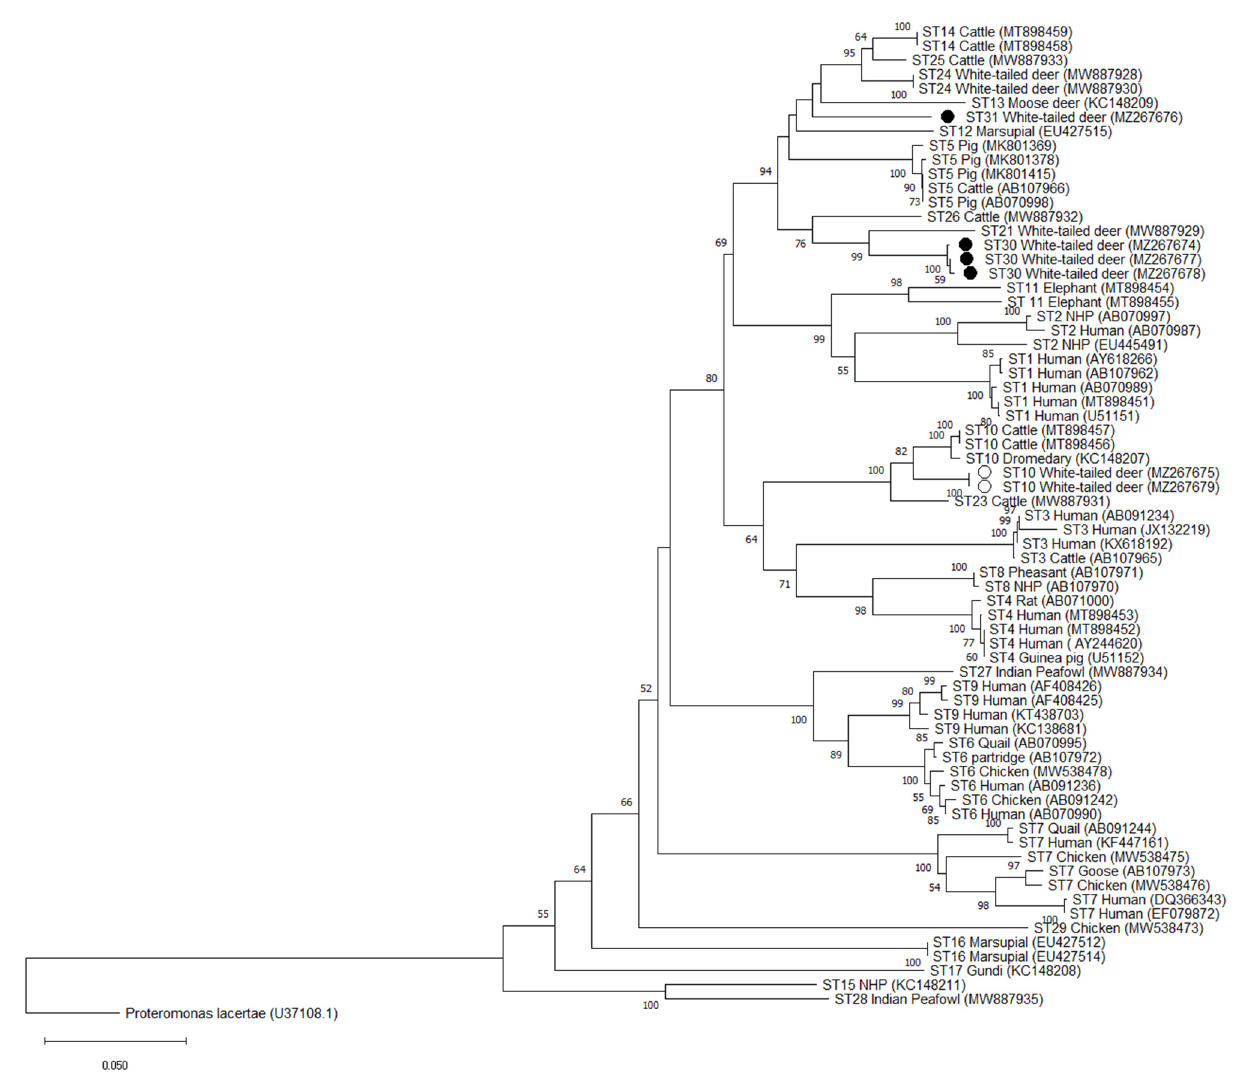
Figure 4. Phylogenetic relationships among Blastocystis Santin region sequences generated in the present study (novel subtypes represented are with a black filled circle and other subtypes with an unfilled circle) and representative reference sequences of all accepted subtypes. Proteromonas lacertae was used as outgroup taxon to root the tree. Analysis was conducted using a neighbor-joining method. Genetic distances were calculated using the Kimura two-parameter model. This analysis involved 70 nucleotide sequences, and there were a total of 571 positions in the final dataset. Bootstrap values lower than 50% are not displayed.